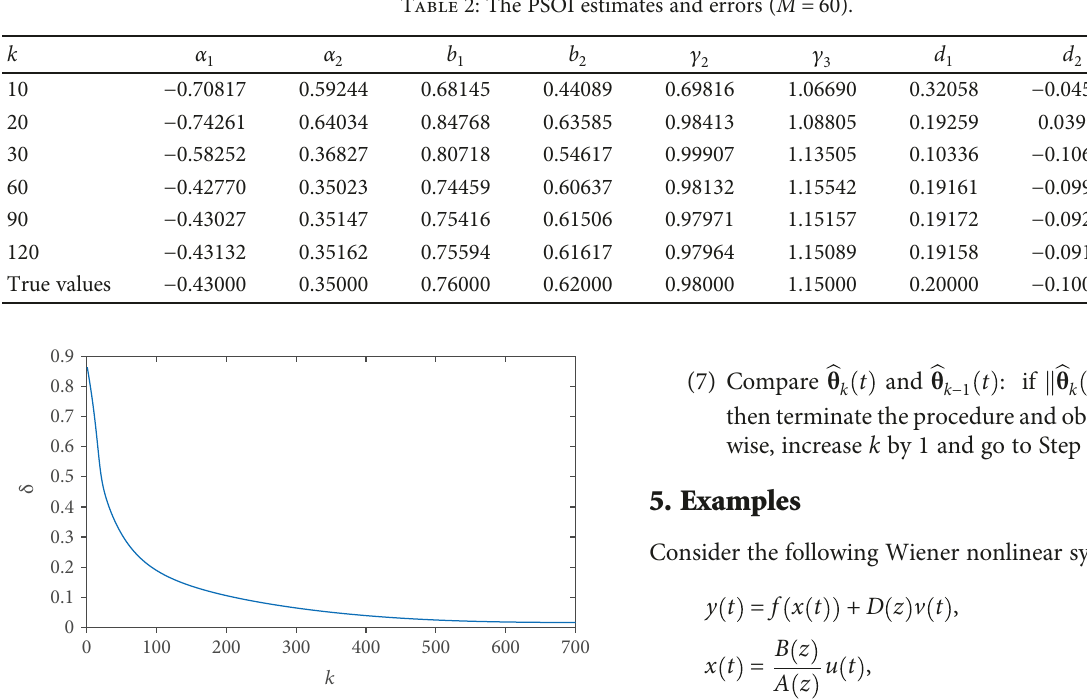
Figure 3: The GI estimation errors versus k .